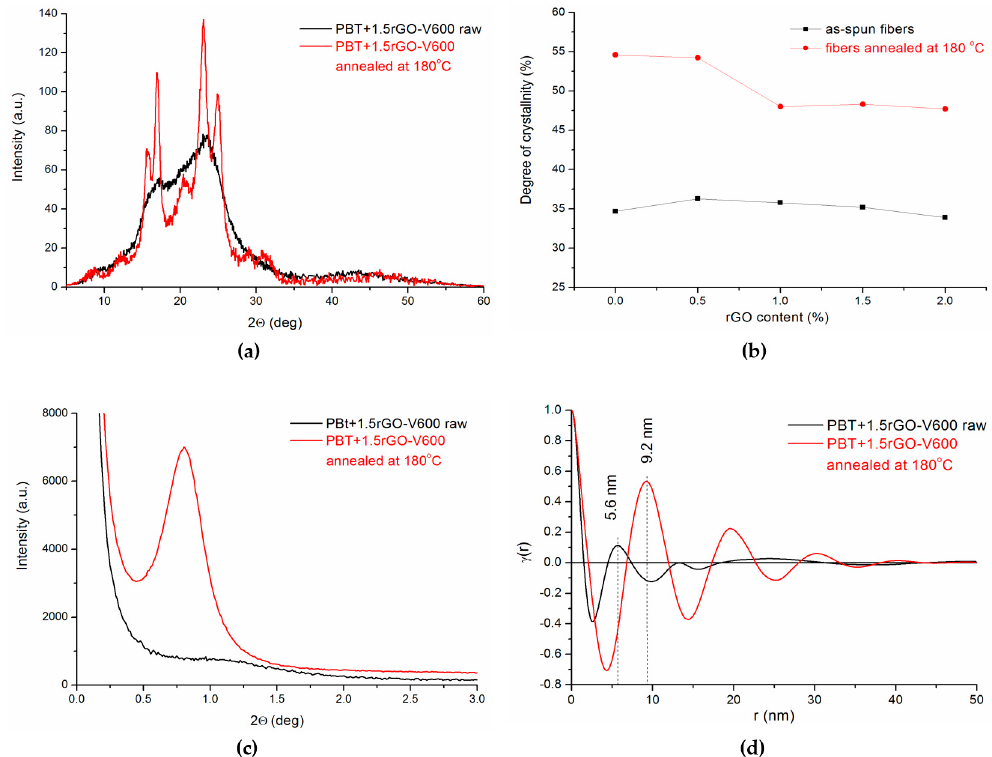
Figure 10. Comparison of ( a ) WAXS patterns; ( b ) crystallinity changes; ( c ) SAXS patterns; ( d ) correlation function for fibers PBT + 1.5 wt %rGO-V600 both before (black line) and after annealing (red line) at 180 °C.